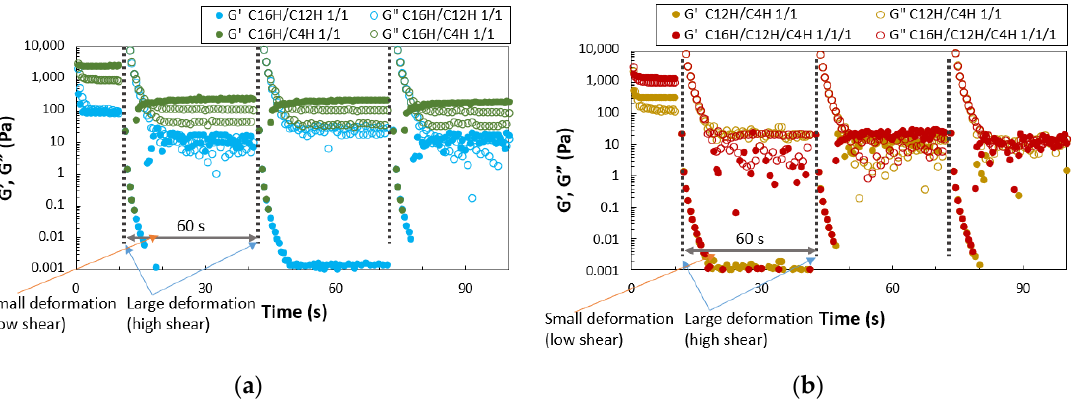
Figure 5. Periodic step-shear test results for the mixed molecular squalane organogels (3.0 wt.%); ( a ) C16H/C12H 1/1 gel and C16H/C4H 1/1 gel, ( b ) C12H/C4H 1/1 gel and C16H/C12H/C4H